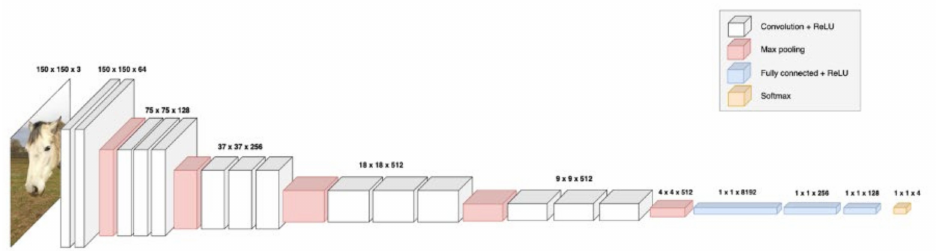
Figure 2. Model architecture.